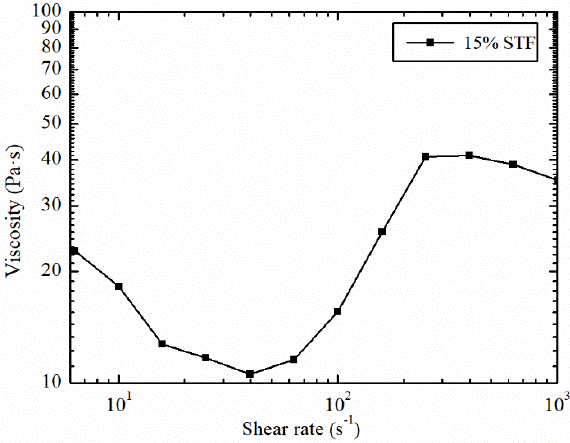
Figure 5. Rheological performance of 15% mass fraction STF.